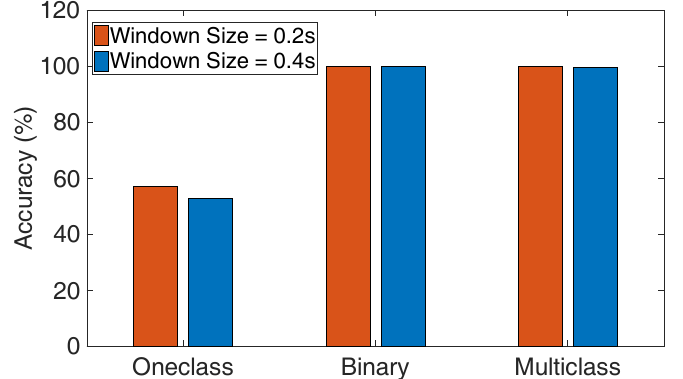
Figure 8. The accuracy of one-class, binary and multiclass classification. The t s and t o are set to 0.4 s, 0.2 s and 0.2 s, 0.1 s.